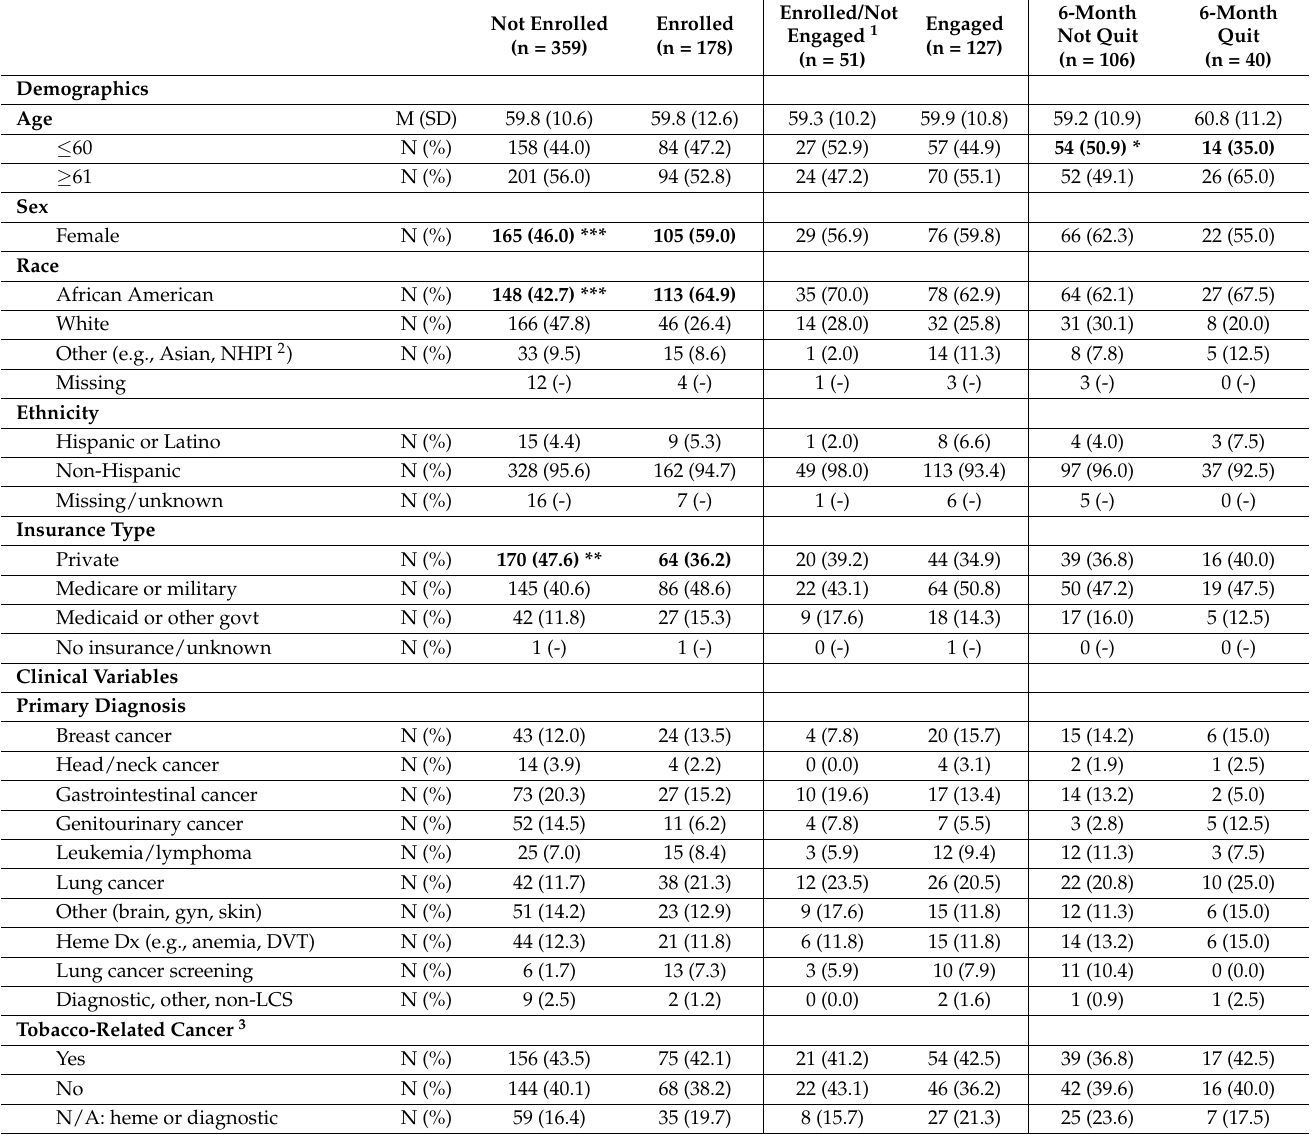
Table 2. MGUH baseline demographic, clinical, and tobacco-related characteristics, by enrollment, engagement, and